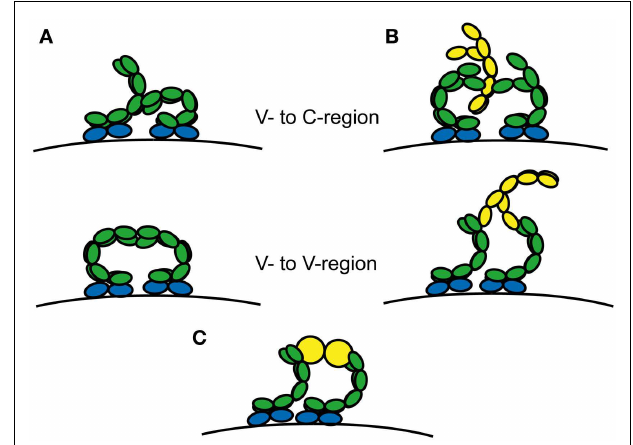
FIGURE 3 |Alternative schematic mechanisms resulting in cytokinergic cross-linking of IgE-Fc ε RI complexes. Complexes are cross-linked (A) by receptor-bound IgE Fabs contacting regions of neighboring IgE-Fc ε RI complexes or (B) by bridging with free IgE or (C) bridging by other proteins such as HRF or autoantigens. Free IgE and HRF dimer or multivalent autoantigen are shown in